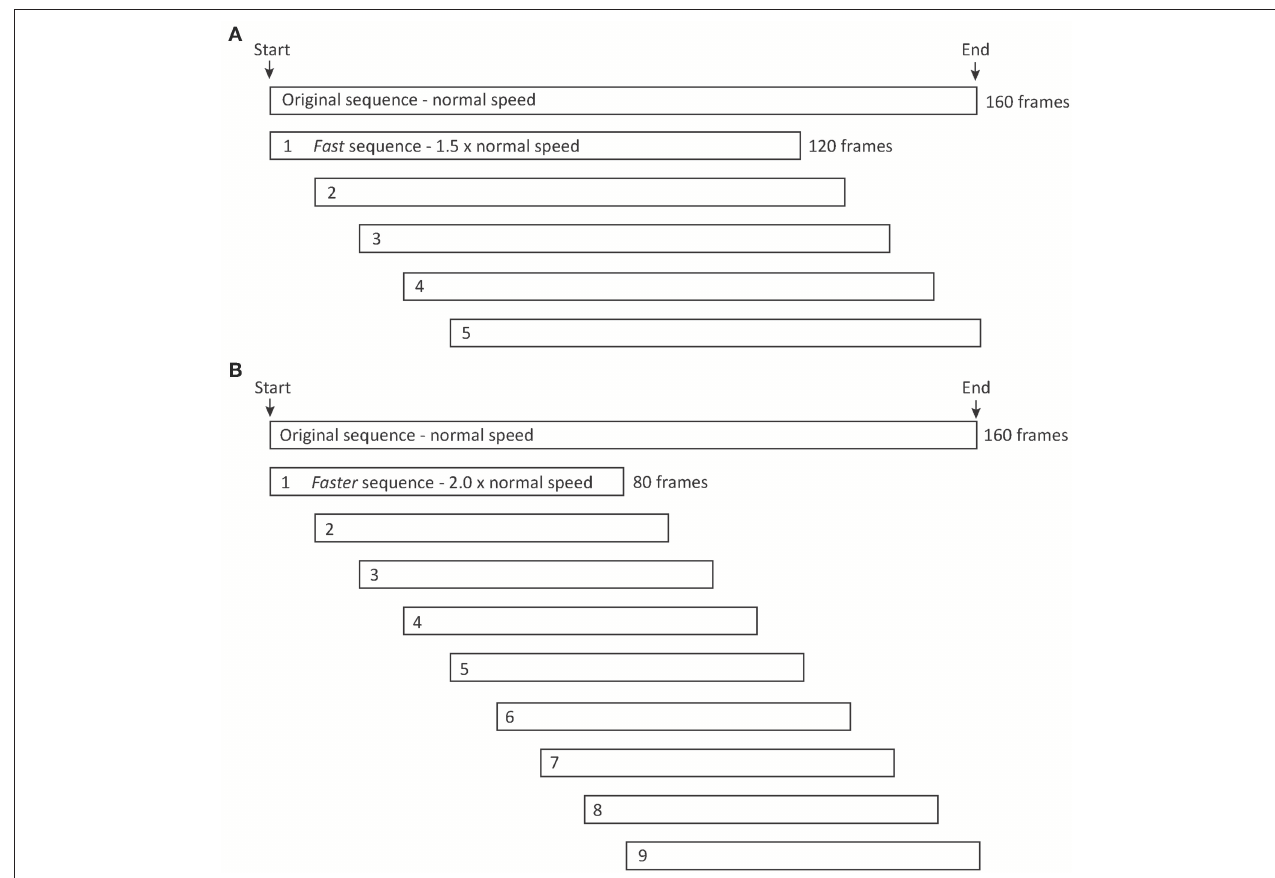
FIGURE 3 | In order to investigate the potential benefit of signaling faster, we compressed the number of frames in the normal speed sequence to represent sequences (A) 1.5 × ( fast ) and (B) 2.0 × ( faster ) the normal speed. Importantly, the sequence and amplitude of movements is the same for each speed, and the process of changing the time-frame over which lizard displays occurs has no effect on other components in the animation, including plant movements. The fast and faster display sequences were completed in a shorter time frame than the normal sequence and therefore seen against different plant motion conditions. To account for this potential source of variation, we created multiple versions of each to ensure the new signal overlaps with all of the background noise of the normal sequence. This was achieved by shifting the starting point by increments of 10 frames (0.4s), resulting in five and nine sequences for fast (A) and faster (B) lizard display